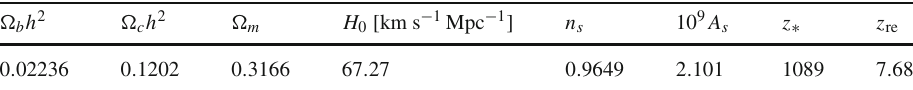
Table 1 The cosmological parameters predicted by Planck 2018 TT, TE, EE + lowE [36]